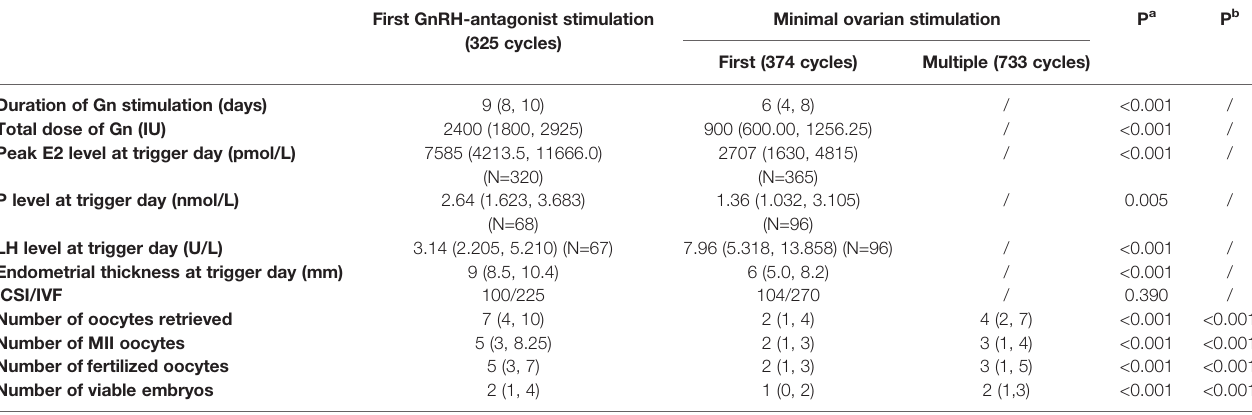
TABLE 2 | Cycle characteristics according to different